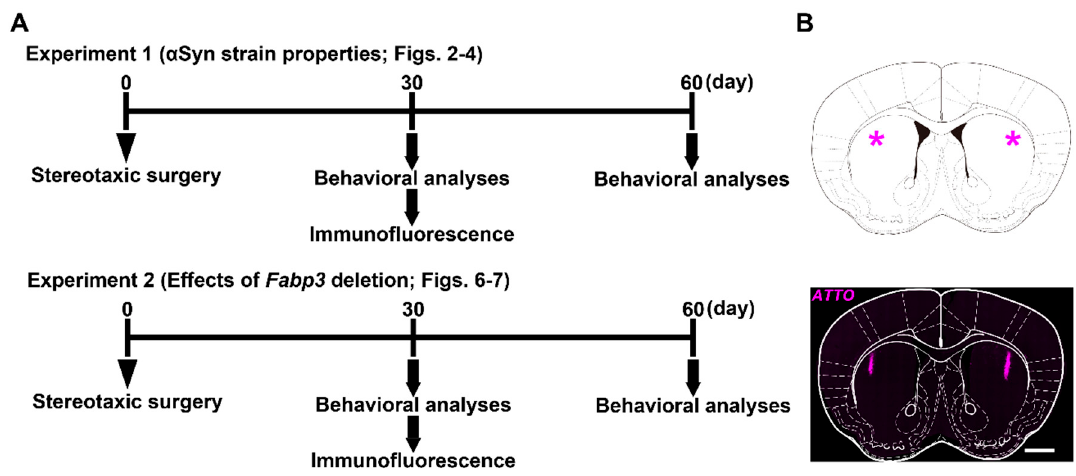
Figure 1. Experimental schedule and the injection site in mouse brain. ( A ) Experimental schedule in this study using intrastriatally α -synuclein ( α Syn)-injected mice. Mice were divided into two groups, received the stereotaxic surgery, and were subjected to either Experiment 1 or 2. Experiment 1 was conducted to reveal α Syn strain-dependent properties regarding cognitive impairment and the related pathological alterations. Mice were injected with α Syn monomers, fibrils, or ribbons. Experiment 2 was conducted using fatty acid-binding protein 3 ( Fabp3) − / − mice to address whether FABP3 participates in α Syn-induced cognitive impairment and the related pathology. Mice were injected with α Syn monomers or fibrils. ( B ) (Top) The injection site (*) is depicted. (Bottom) The actual site confirmed by direct visualization of immunoreactivity against ATTO550 (magenta). The image was obtained 30 days after the injection of α Syn fibrils and was overlaid on the diagram shown above. Scale bar: 1